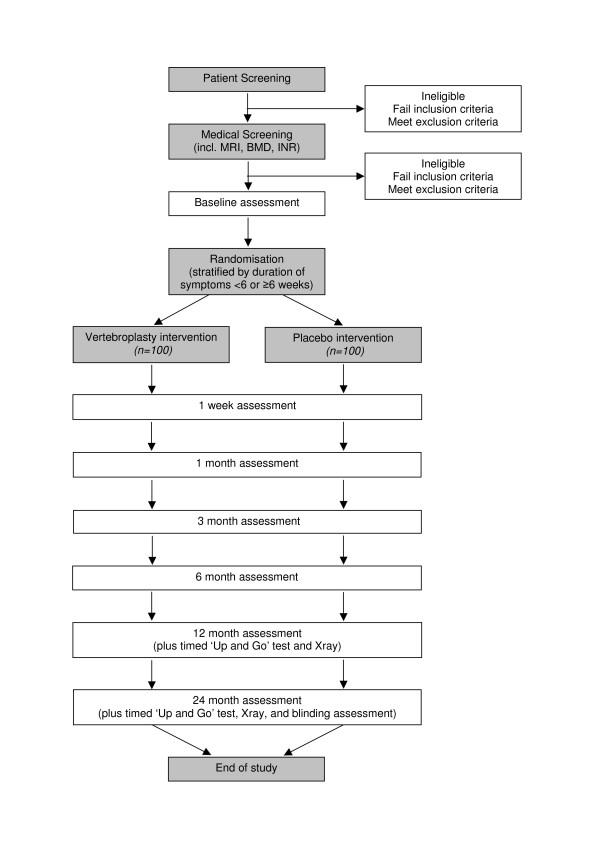
Diagram of Recruitment and Participation Process.